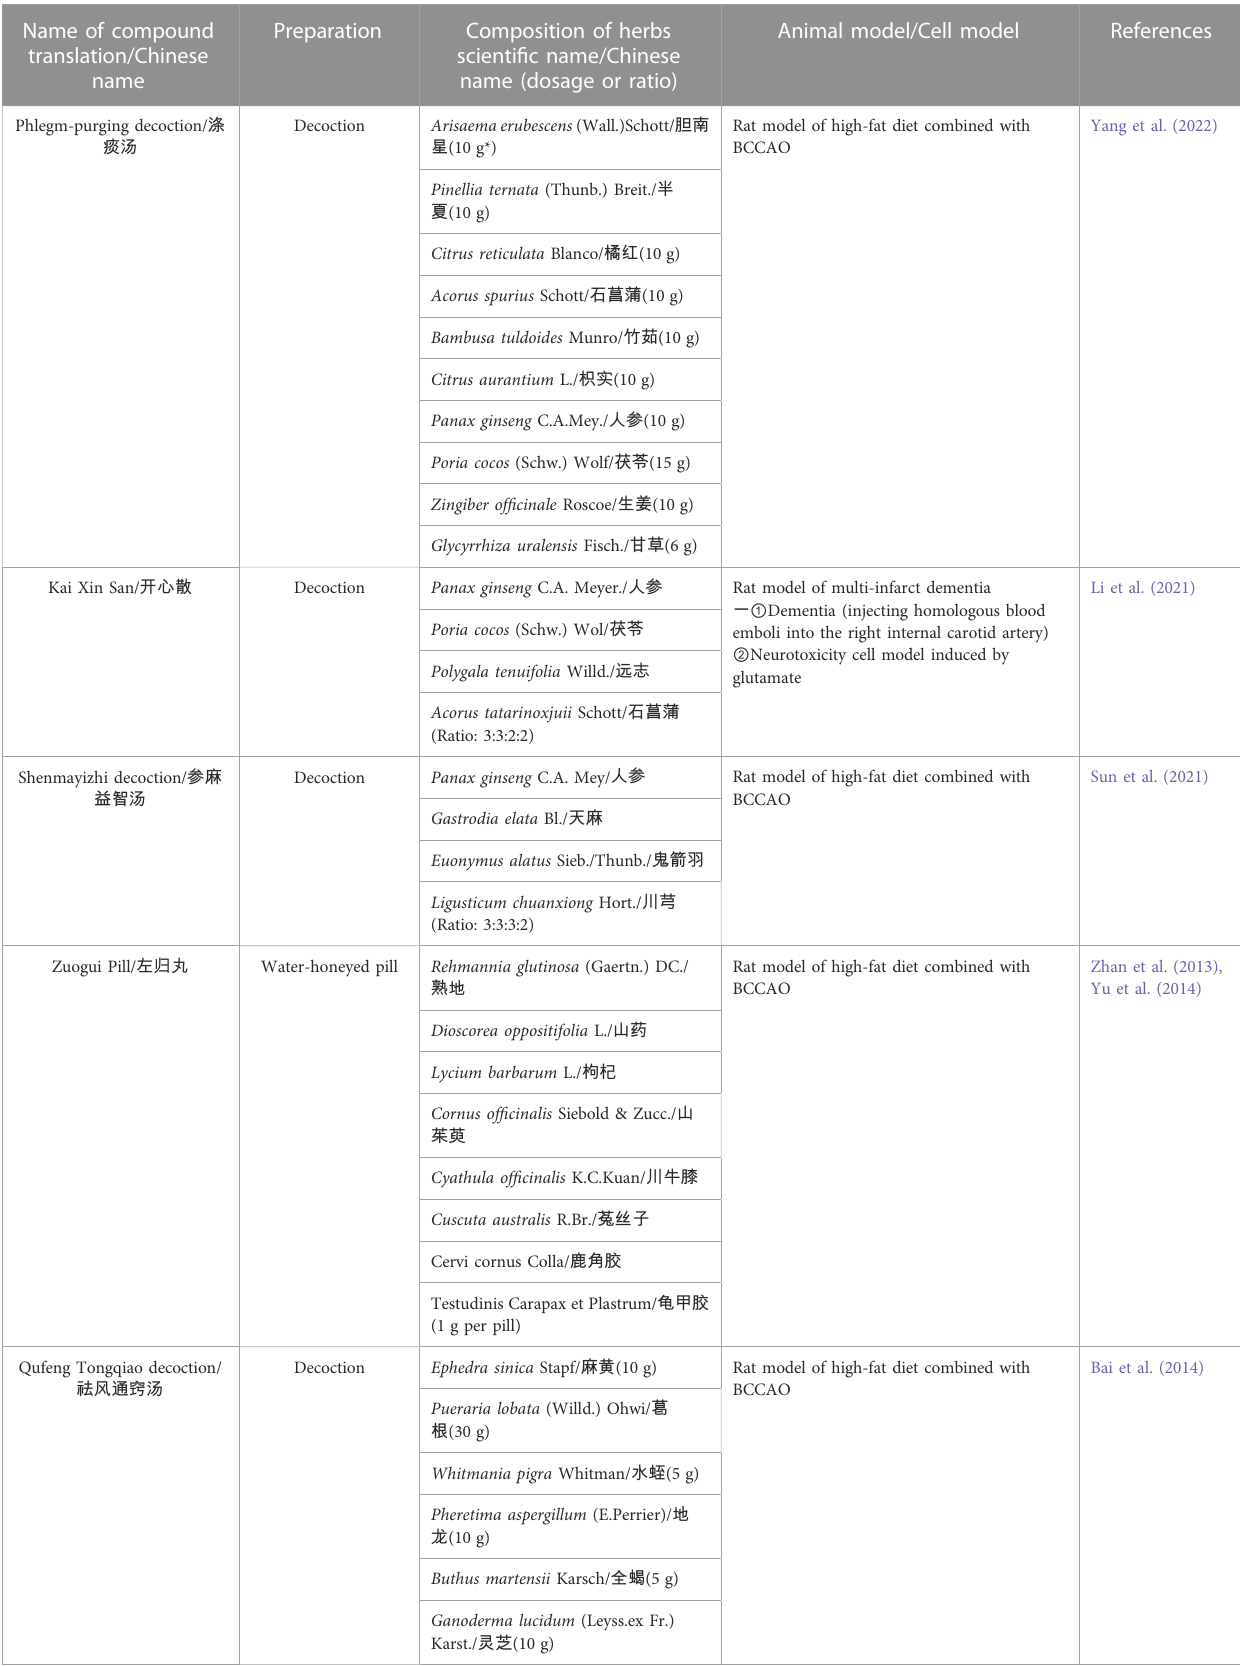
TABLE 1 Composition of Chinese herbal compounds targeting mitochondria after CCH. Name of compound